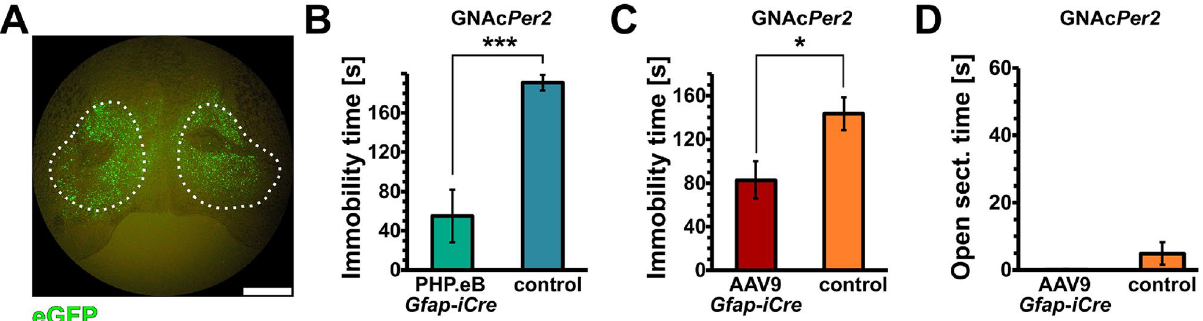
Figure 6. Deletion of Per2 in glia of the NAc evokes reduced despair but has no effect on anxiety-related behavior. ( A ) Injection of the AAVs into the NAc as revealed by the eGFP reporter fluorescence. White dotted area delineates the NAc. Scale bar: 1 mm. ( B ) Immobility time in the forced swim test (FST) of PHP.eB Gfap- iCre (green) and non-injected control ( Per2 fl/fl , blue) animals is shown (n = 4 or 5, respectively, two-tailed t-test, *** P < 0.001). ( C ) FST of AAV9 Gfap-iCre Per2 fl/fl (red) and Gfap - iCre Per2 WT littermate control (orange) NAc injected mice is shown (n = 7 or 8, two-tailed t-test, * P < 0.05). Deletion of glial Per2 in the NAc with both types of AAV capsid, but same expression cassette, appears to be sufficient to evoke reduced despair. ( D ) Time spent in the open area of the O-maze is similar in both NAc injected AAV9 Gfap-iCre and AAV9 control animals, suggesting no effect of Per2 glial deletion in the NAc on anxiety-related behavior (n = 7 or 8, two-tailed t-test, P >